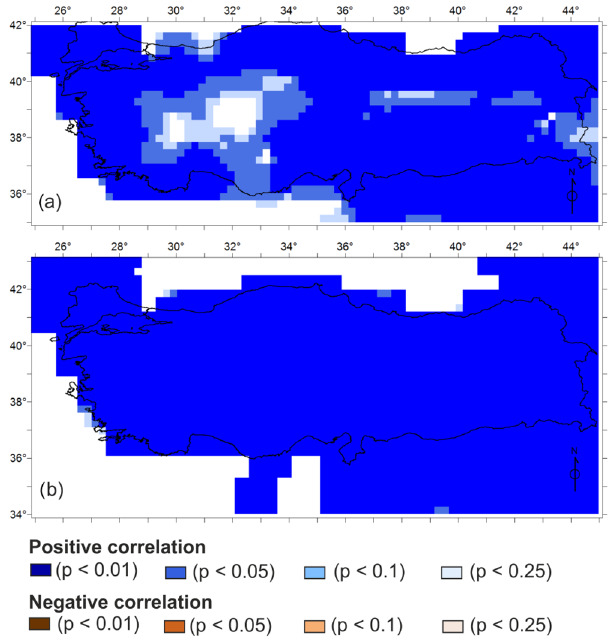
Figure 11. The correlation between total precipitation and runoff for a) ERA-Interim and b)